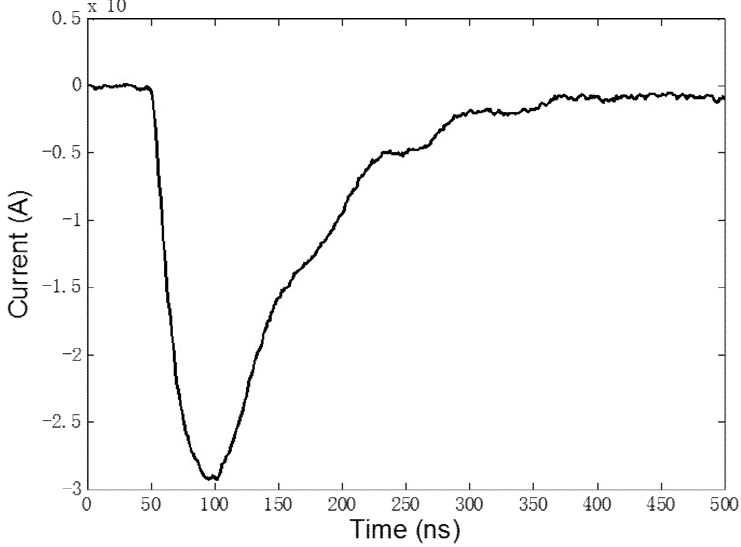
Figure 11. Single Trichel pulse current waveform.